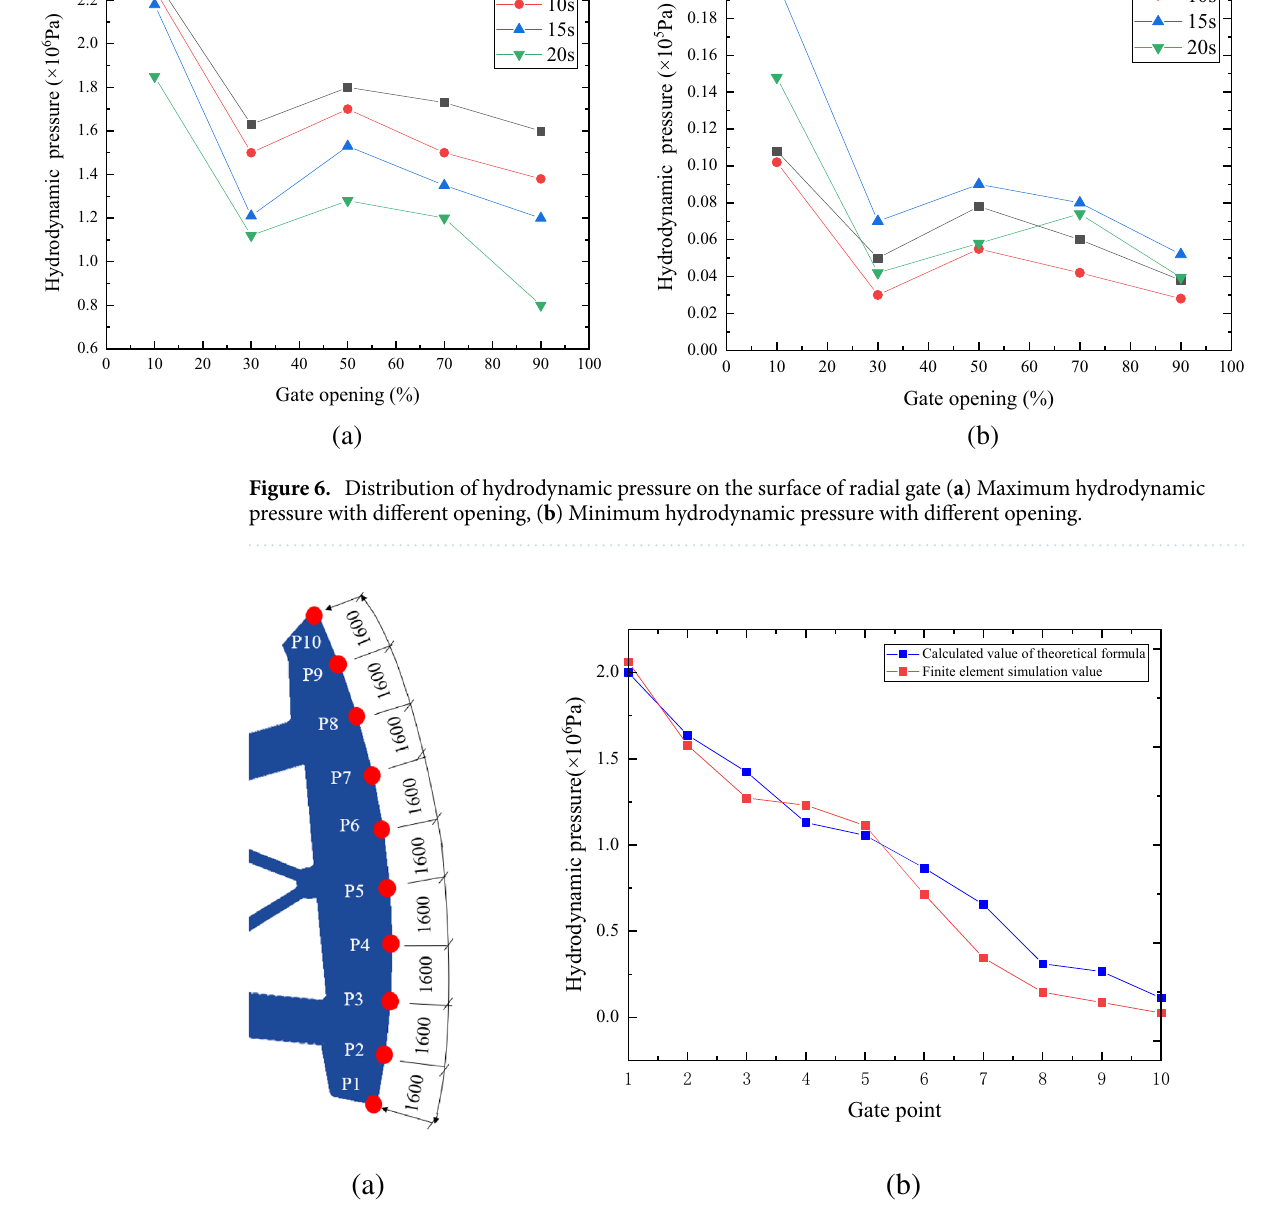
Figure 7. Comparison of theoretical calculation results and finite element simulation results. ( a ) Location map of calculation points, ( b ) Hydrodynamic pressure along the radial gate